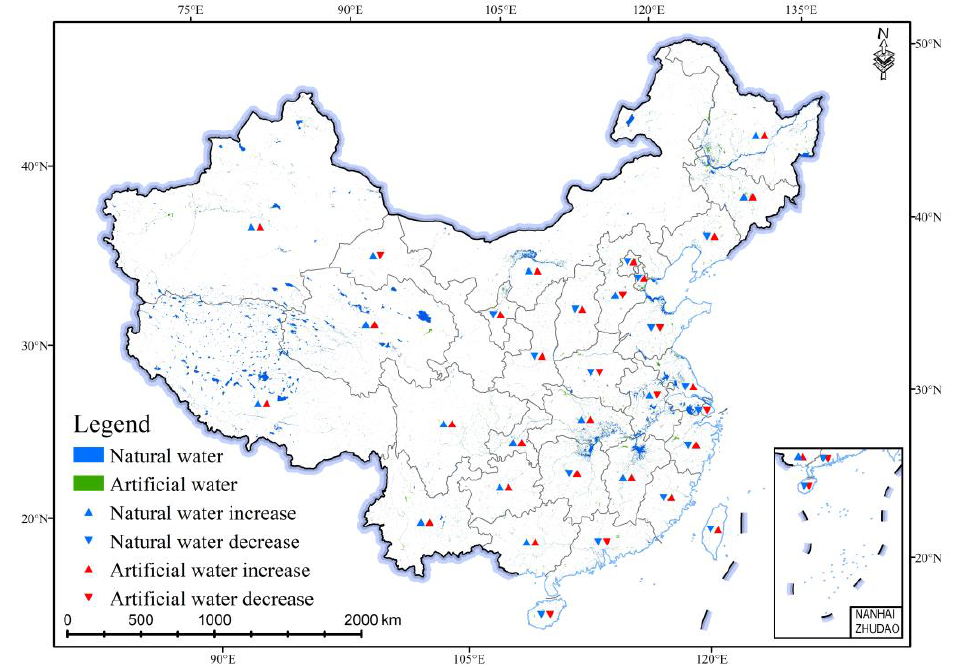
Figure 6. The spatial distribution of artificial and natural water bodies in China in 2020 and the change trend of artificial and natural water bodies in each provincial administrative region from 2015 to 2020 compared with 2000 to 2005.